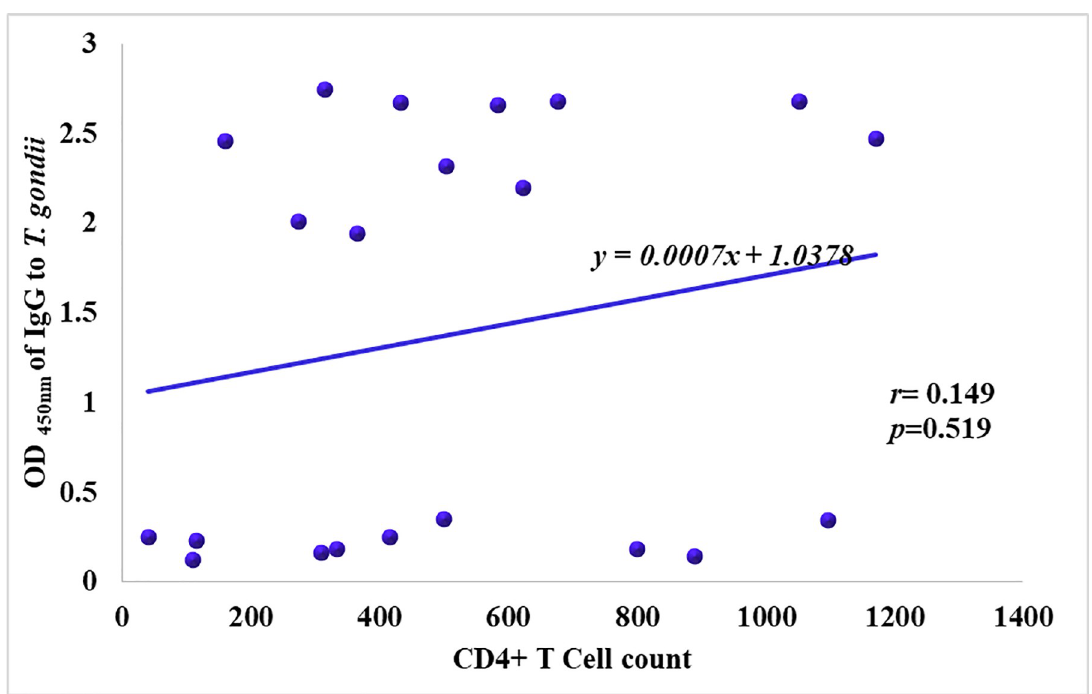
Fig 3. IgG antibodies against Toxoplasma infection and CD4+ T cell count in HIV